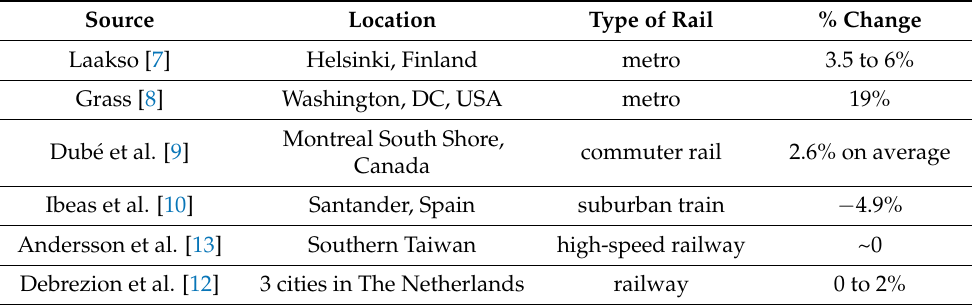
Table 1. Findings in the literature on the effects of railway on residential property prices.